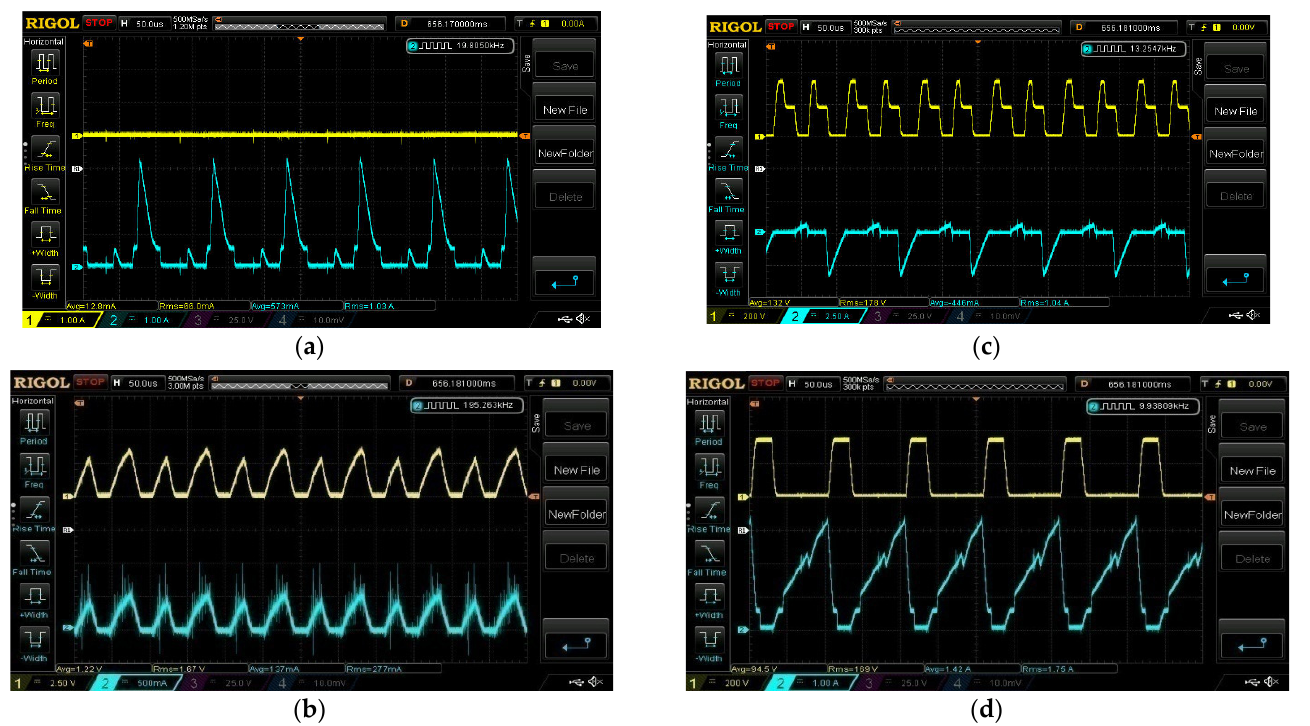
Figure 14. Experimental Wave Form of Switch and Diode in ESS Discharging Domain.